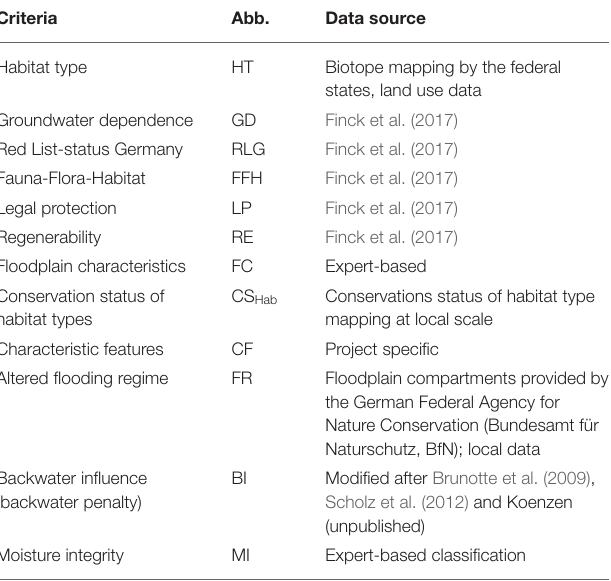
TABLE 6 | Data sources used in calculating the habitat provision index.